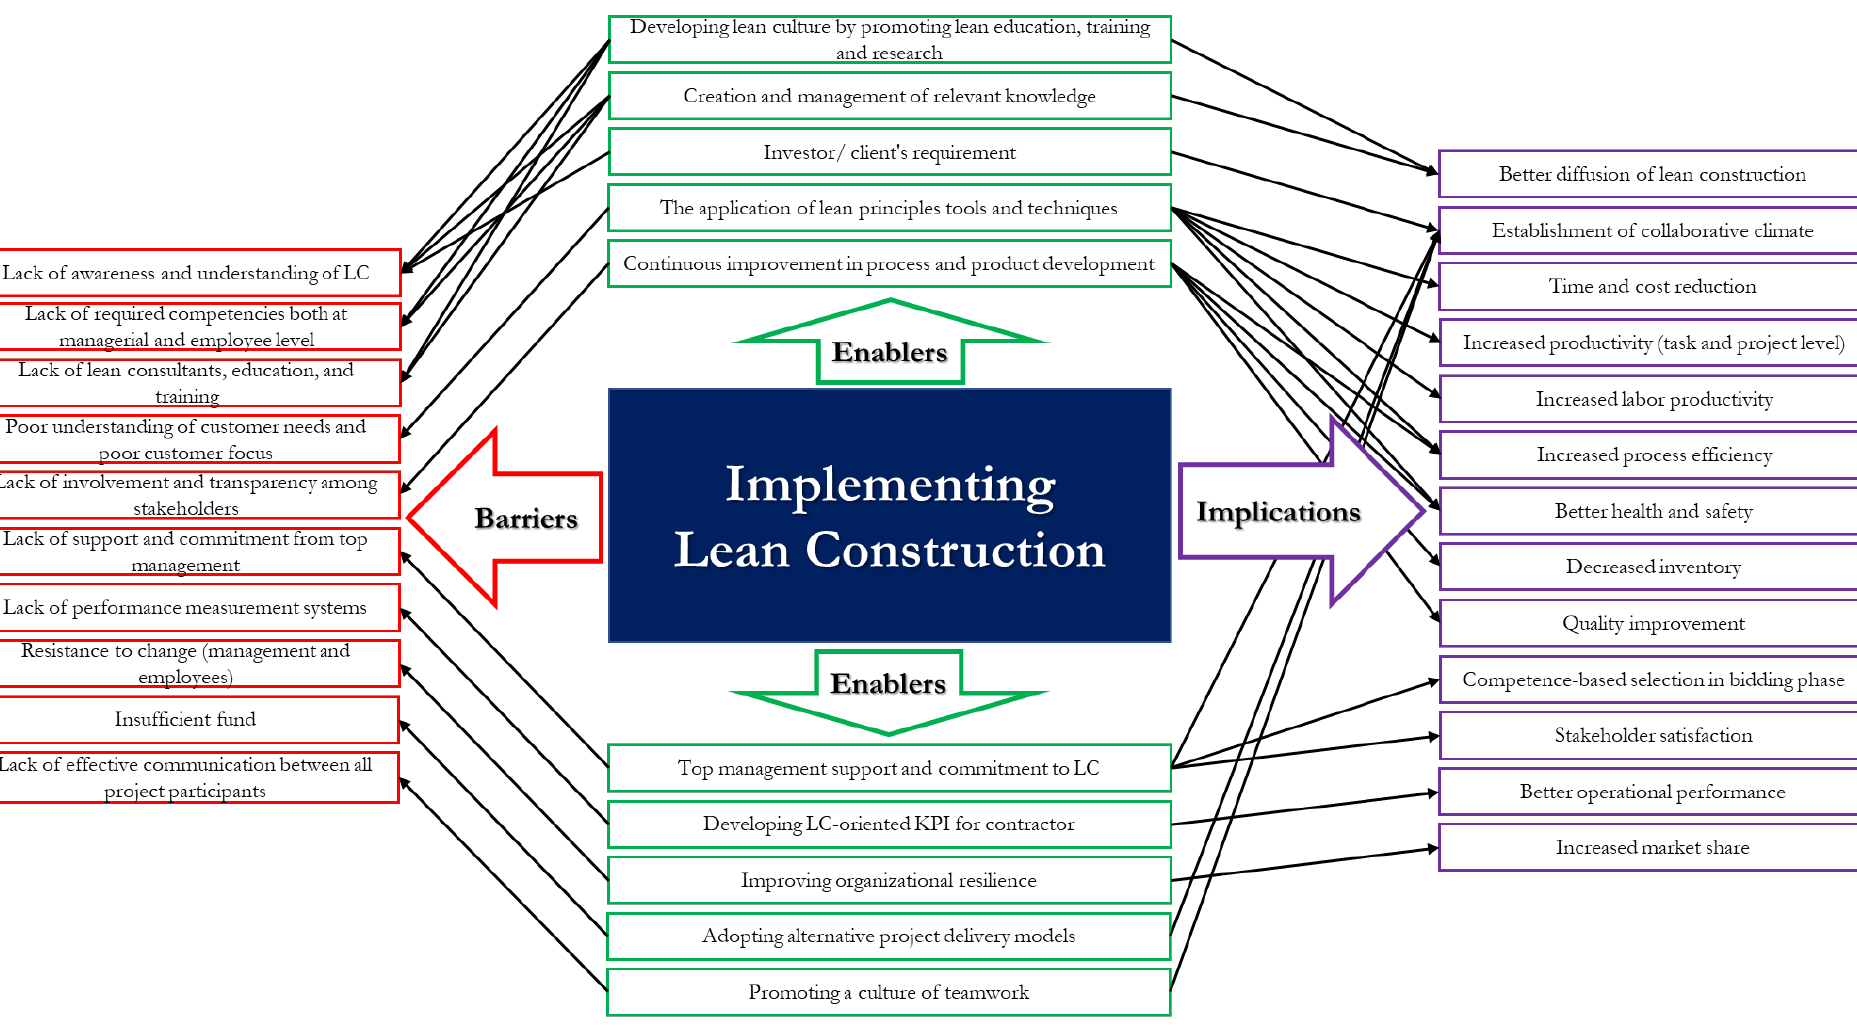
Figure 3. Relatedness between LC-implementation barriers, enablers, and implications.